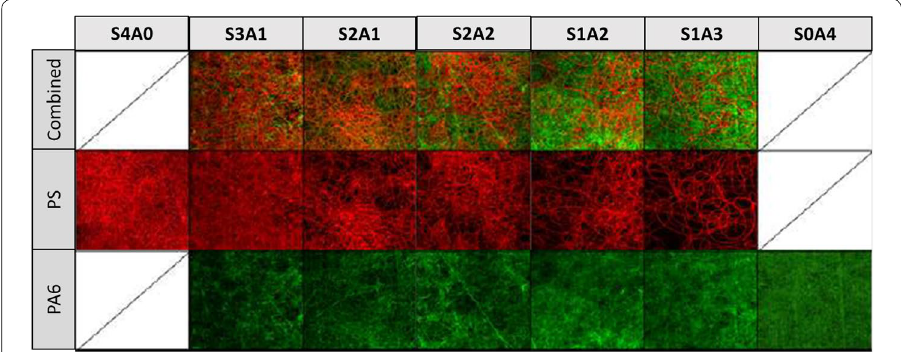
Fig. 2 Confocal microscopy images for the dyed PS/PA6 blend webs: red represents PS fibers and green represents PA6